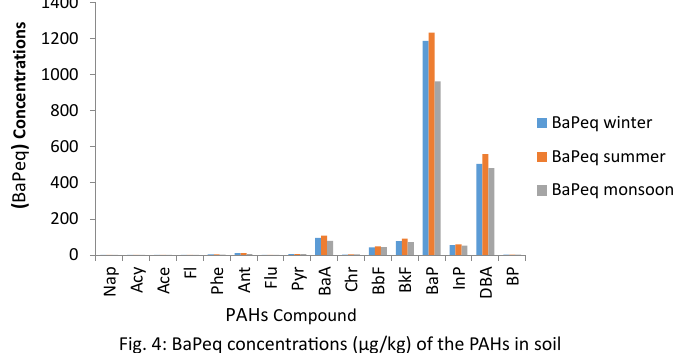
Fig. 4: BaPeq concentrations (µg/kg) of the PAHs in soil